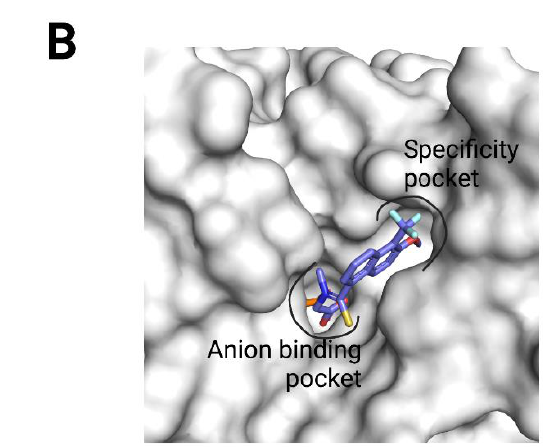
Figure 2. Overview of the AKR1B10 three-dimensional structure. ( A ) Crystal structure of AKR1B10 complexed with NADP + (orange) and tolrestat (violet, PDB ID 1ZUA), with side view of the (α/β) 8 barrel, with α helices in red, β sheets in yellow and loops in green. ( B ) Surface representation of the structure, indicating location of the anion-binding pocket (ABP) and specificity pocket (SP). ( C ) Atomic model describing interactions of the tolrestat molecule in the AKR1B10 – NADP + – tolrestat complex. ( D ) 2D representation of the previous. Created with PyMoL 2.3.0. and in biorender.com. Hence, considering this anchoring moiety, we can broadly divide AKR1B10 inhibi- tors into two types: carboxylic acid- and non-carboxylic acid-containing inhibitors (here- inafter, CAIs and NCAIs, respectively). Section 3.2. will provide relevant examples and binding insights of each class whose structure in complex with the AKR1B10 holoenzyme (AKR1B10-NADP + ) has been solved. 2.2. AKR1B10 Covalent Inhibitors Despite its wide use in medicine (e.g., aspirin, penicillin, acetaminophen), there has been some reluctance in pursuing covalent inhibition in drug discovery until recently, because of off-target binding and potential toxicity. This tendency has reversed upon FDA-approval of several covalent drugs [27]. Accordingly, covalent inhibition of AR or other human AKR1s such as AKR1B10 is an unexploited strategy. Both AR and AKR1B10 possess a reactive cysteine (Cys298/Cys299, respectively) in their active site [22,28]. Nev- ertheless, there is a lack of thorough understanding of its in vivo role if any. Indeed, Cys298 in AR is highly nucleophilic and can be reversibly or irreversibly modified by different reactive species such as nitric oxide (NO), 4-hydroxynonenal (HNE, Figure 1), or oxidized glutathione (GSH, Figure 1) in both recombinant protein and ex vivo models [29]. These modifications can reduce or increase the catalytic activity of AR, depending on the modifying moiety, and reduce its susceptibility to some non-covalent